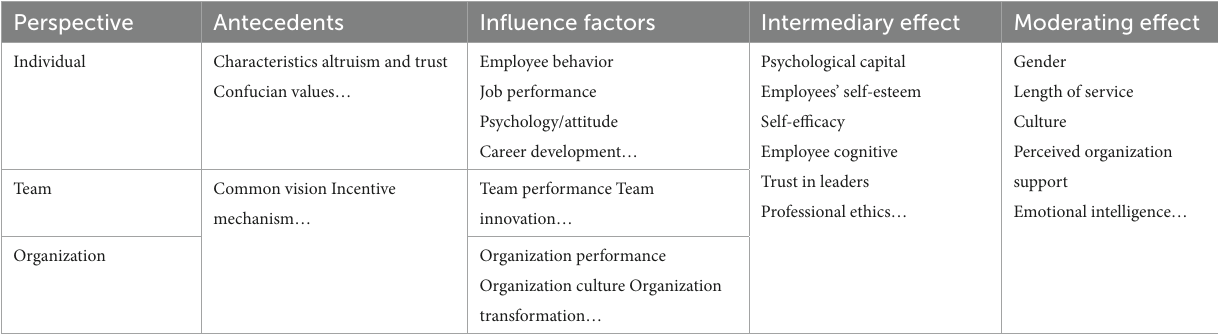
TABLE 1 Partial results of empirical studies on spiritual